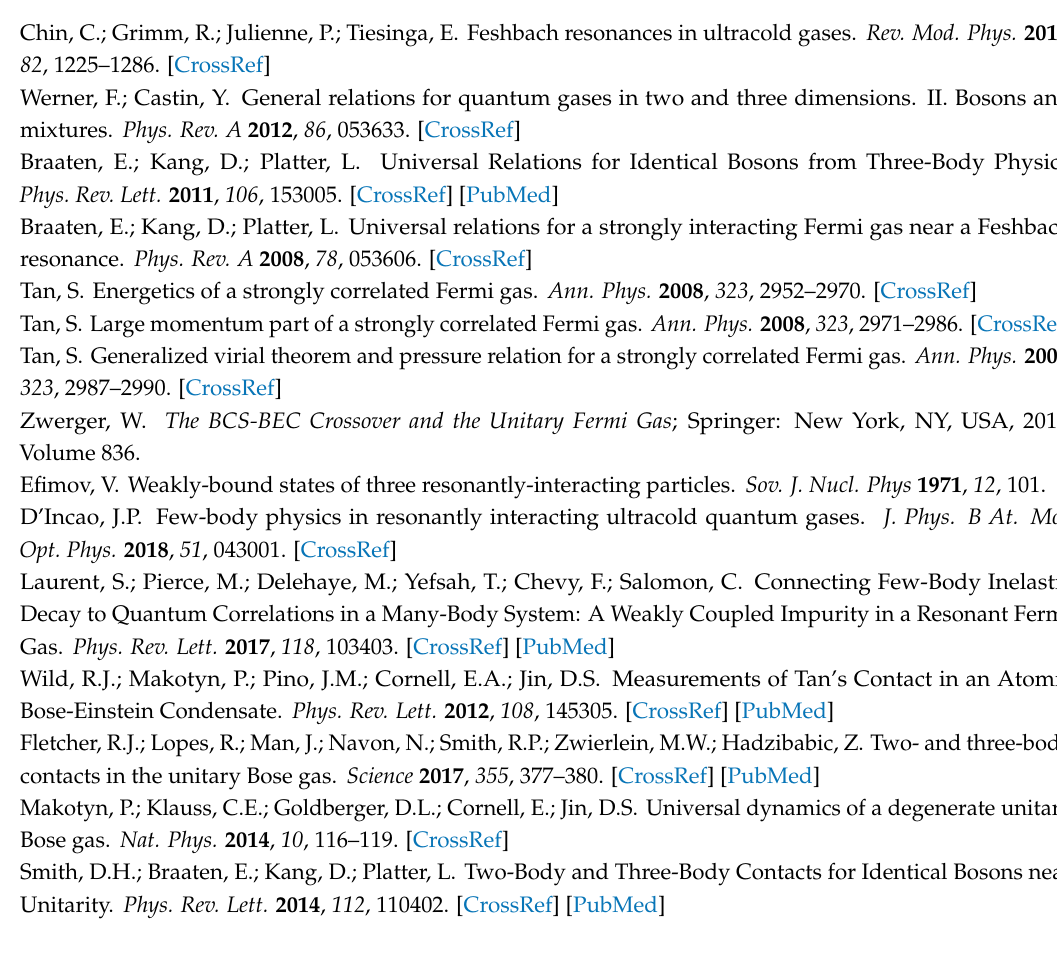
C 3 in this work with the results of ho